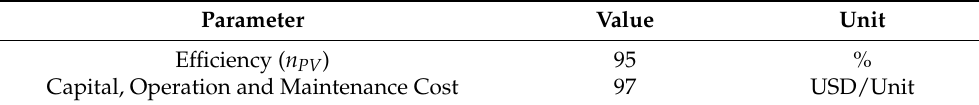
Table 1. PV cost